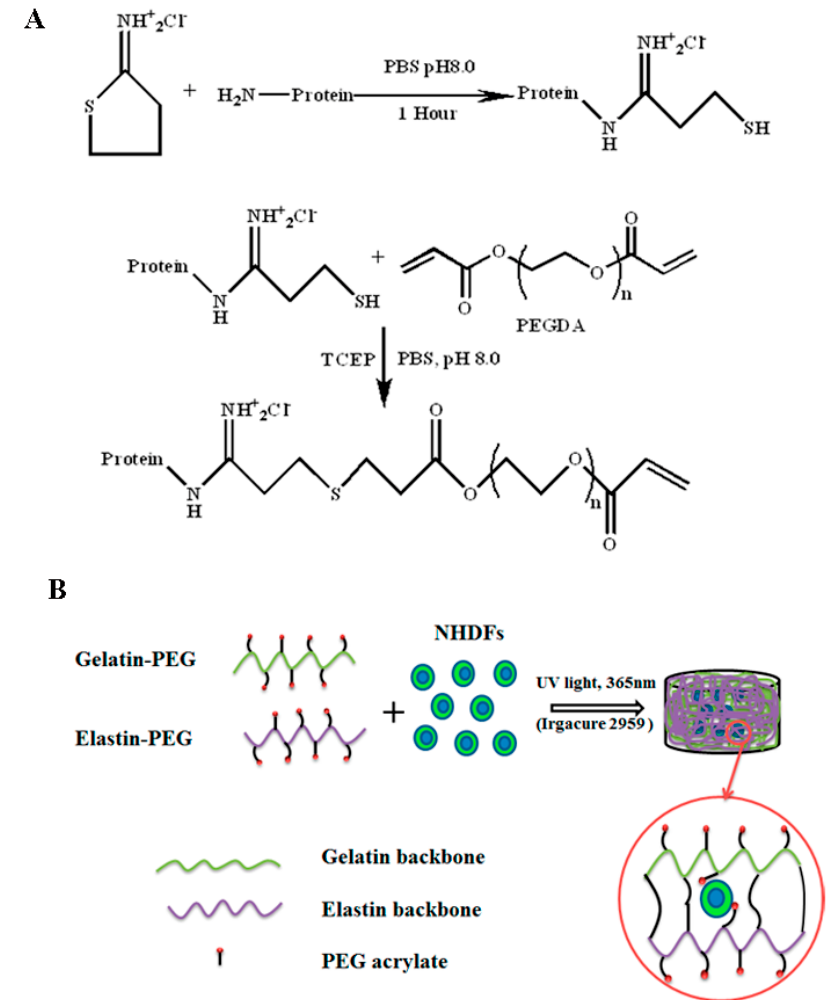
Figure 1. ( A ) Synthesis of gelatin–Polyethylene glycol-acrylate (Gelatin-PEG) and elastin– Polyethylene glycol-acrylate (elastin-PEG) precursor. Gelatin and elastin were modified with free sulfhydryl group on the backbone via reacting with Traut’s Reagent. ( B ) Cell encapsulation in 3D hydrogel via UV photopolymerization. (NHDFs: Neonatal human dermal fibroblasts).